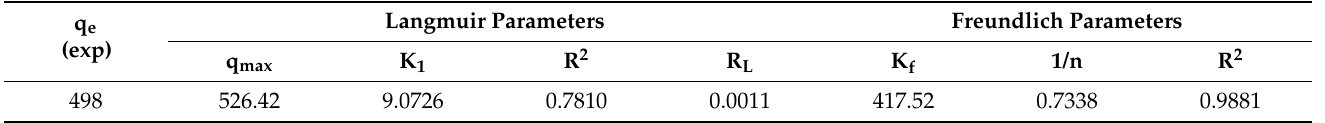
Table 1. Langmuir and Freundlich’s isotherm models of nitrate adsorption onto ZLCH-Fe. Langmuir Parameters Freundlich